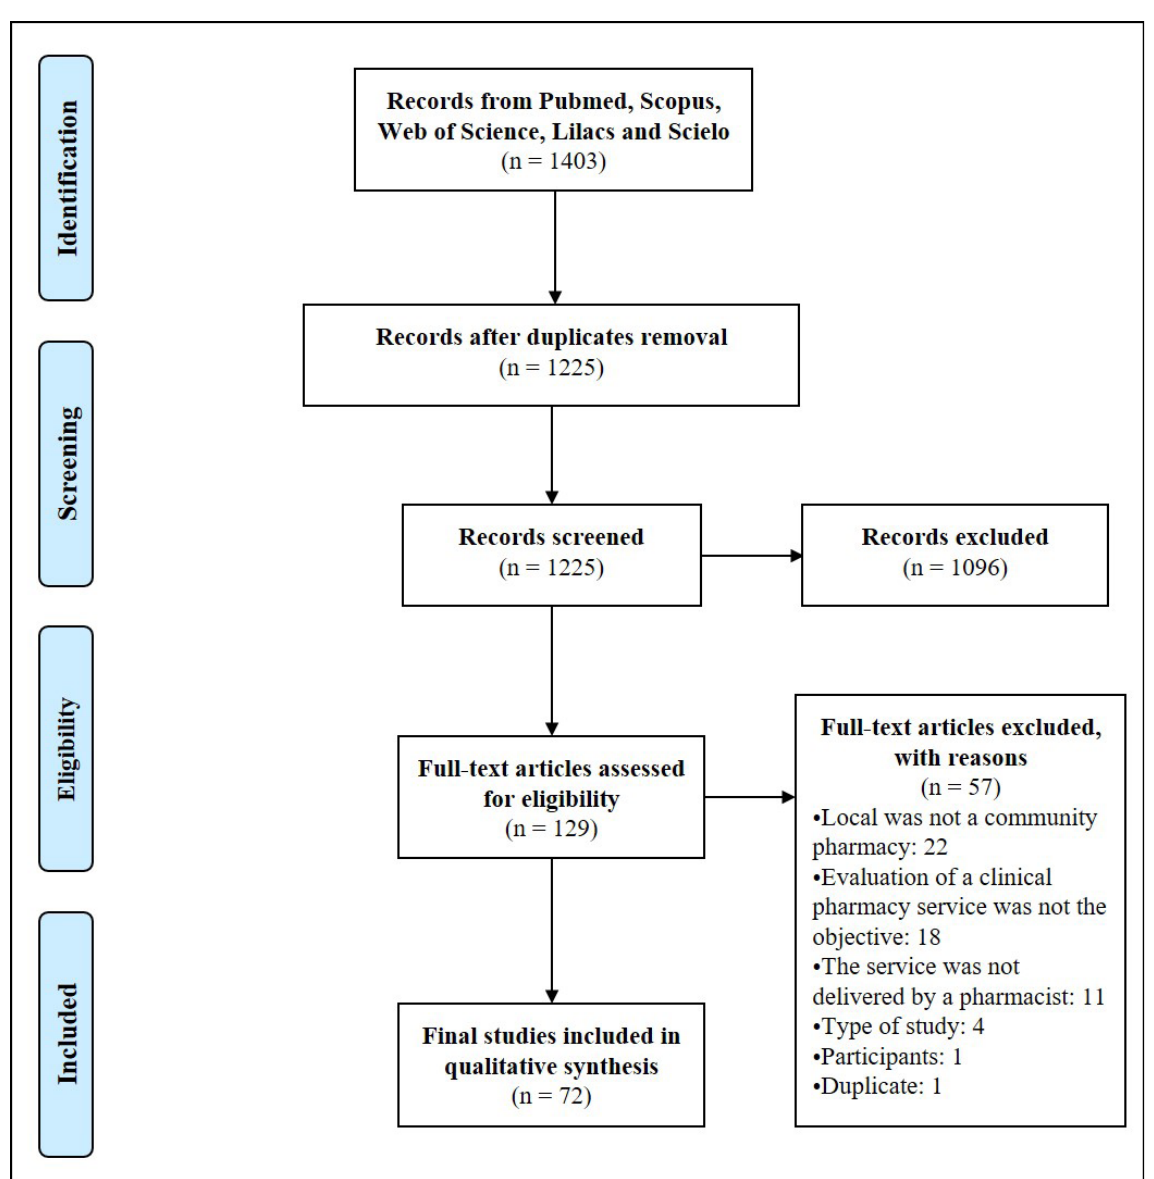
FIGURE 1 - Flowchart of the literature selection for this scoping review. TABLE I - S ummary of the data from studies included in the scoping